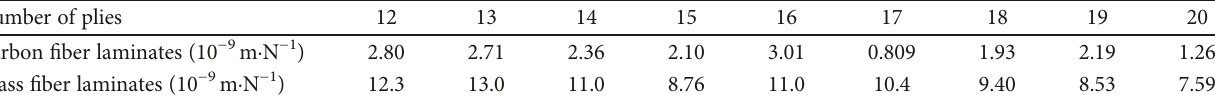
Table 3: Maximum extension-shear-coupled e ff ect of two single-composite laminates.